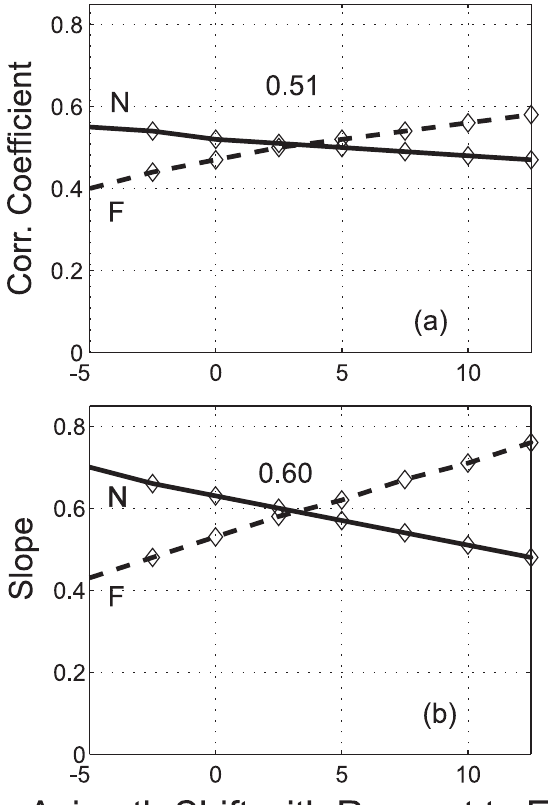
Fig. 9. The same as in Fig. 5, except for the model based on the assumption that the observed STARE velocity is the l-o-s compo- nent of the E × B drift scaled down due to the aspect angle effect and echo reception from various electrojet heights (Uspensky et al.,